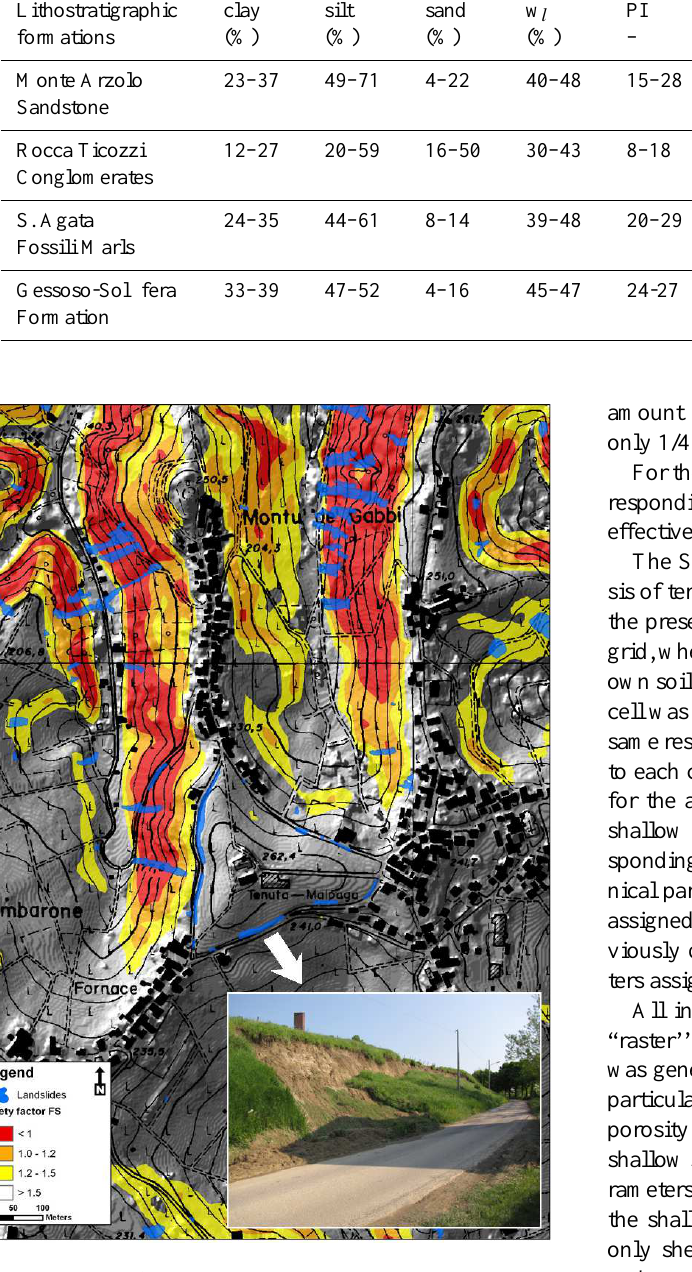
Figure 9. Landslides of type c) near “Tenuta Malpaga” in the municipality of Canneto Pavese. 3